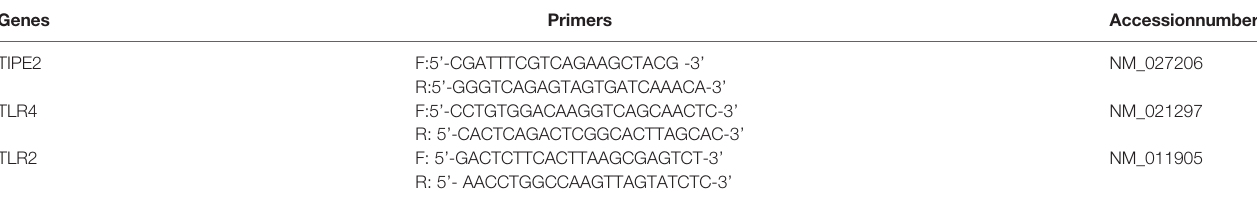
TABLE 1 | Primers for reverse transcription-polymerase chain